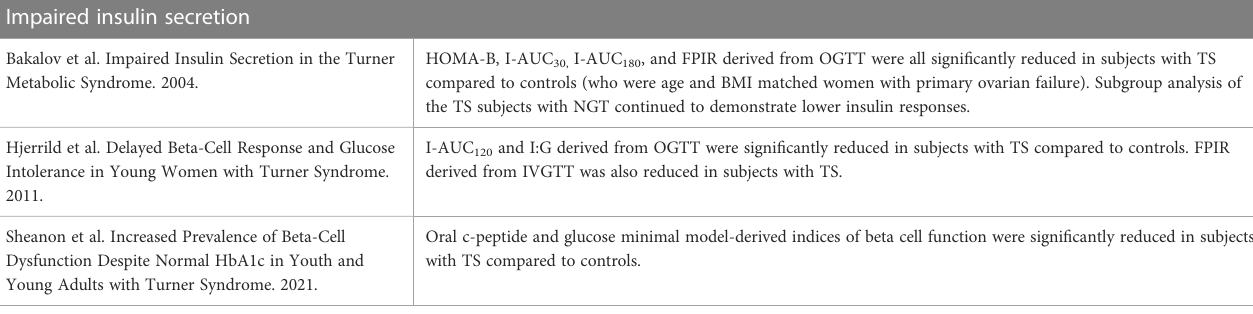
TABLE 4 Summary of key studies evaluating insulin secretion as a potential mechanism contributing to TS-associated hyperglycemia in. Impaired insulin secretion Bakalov et al. Impaired Insulin Secretion in the Turner Metabolic Syndrome.